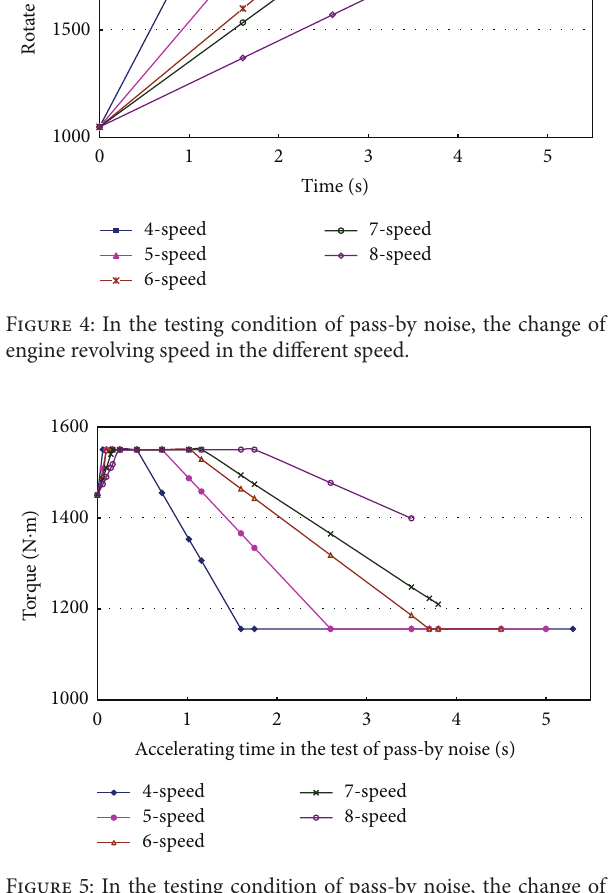
Figure 5: In the testing condition of pass-by noise, the change of engine torque in the different